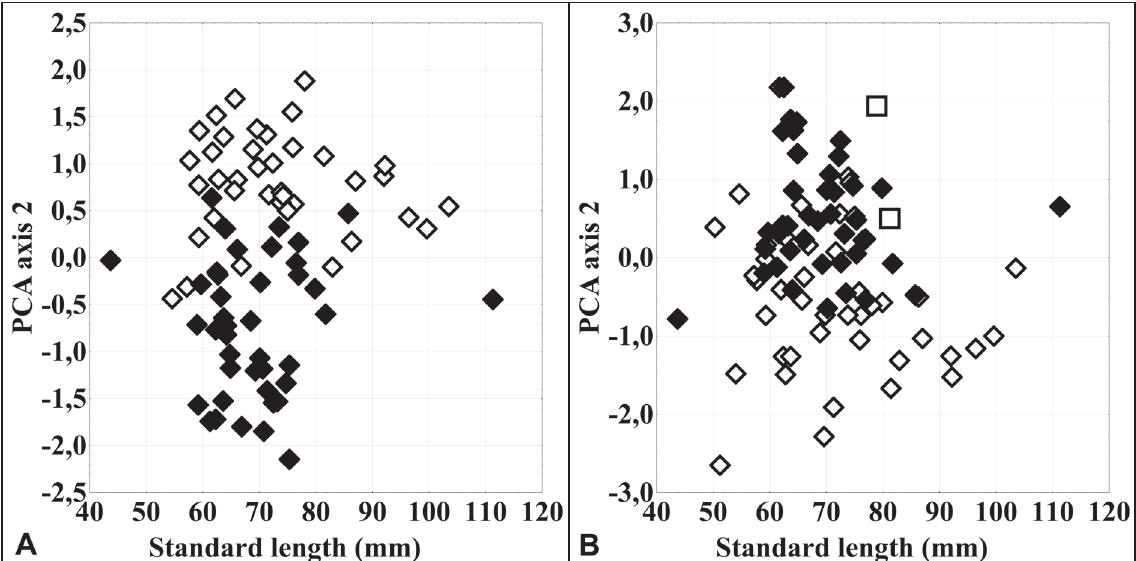
Fig. 4. Plots of the scores on the second axis of a PCA on the log-transformed measurements of Lake Tanganyika specimens against standard length, (A) including and (B) excluding lower pharyngeal bone measurements. Lukuga River (□), Malagarazi basin ( ); Rusizi basin (